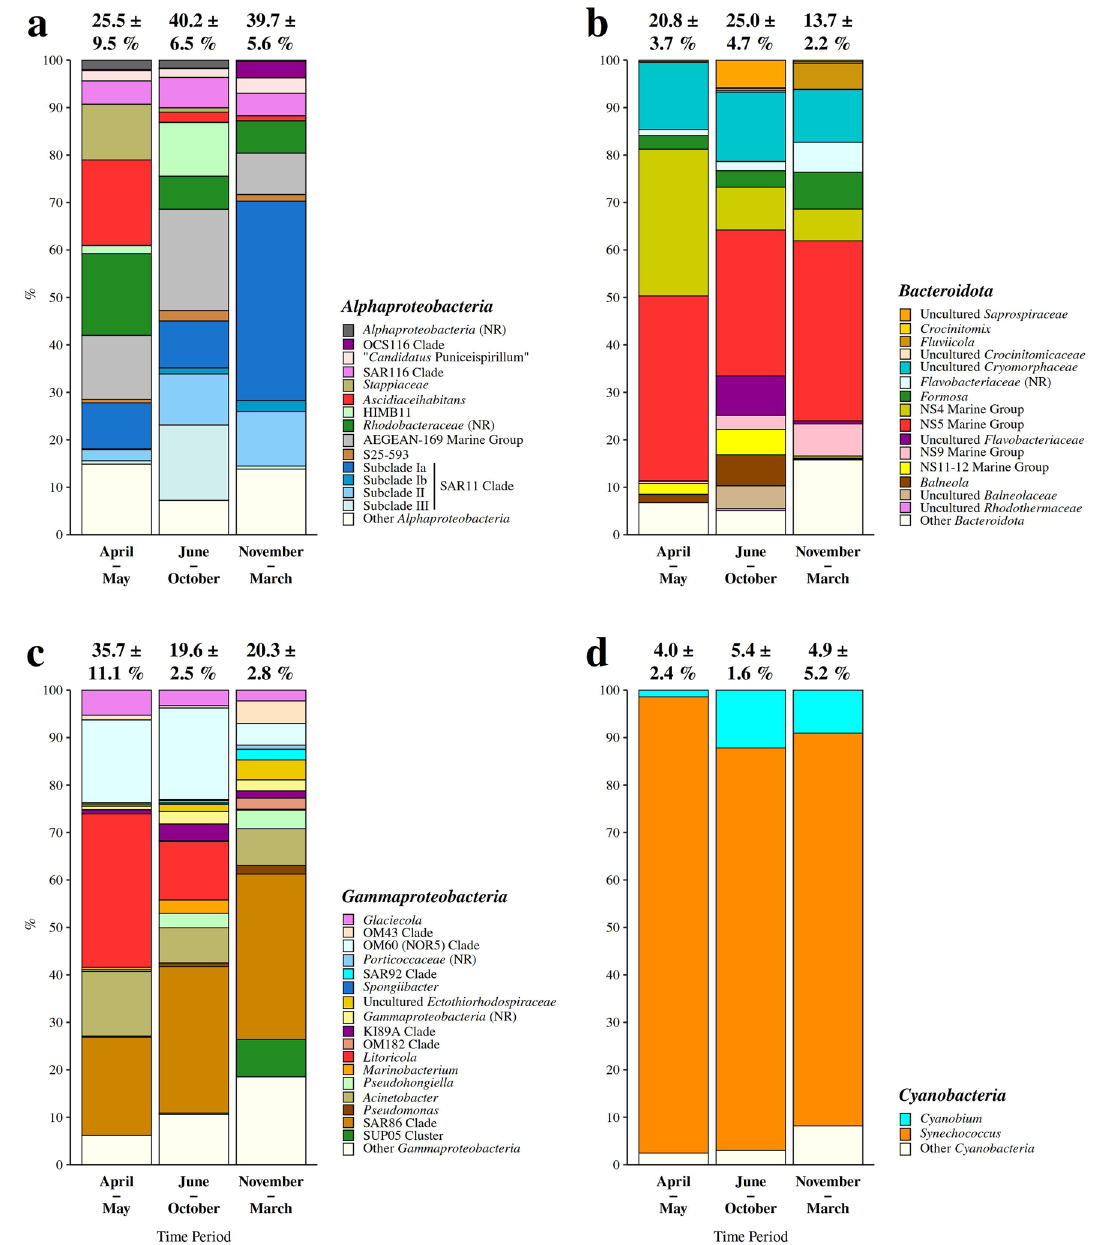
Figure 3. Taxonomic classification and relative contribution of the most abundant sequences within Alphaproteobacteria (≥ 2 %) ( a ), Bacteroidota (≥ 1 %) ( b ), Gammaproteobacteria ( ≥ 1 %) ( c ), and Cyanobacteria (≥ 1 %) (d) during different time periods. The proportion of sequences classified into each of these taxa in the total bacterial and archaeal community is given above the corresponding bar. NR – No Relative (sequences without known relatives within the corresponding